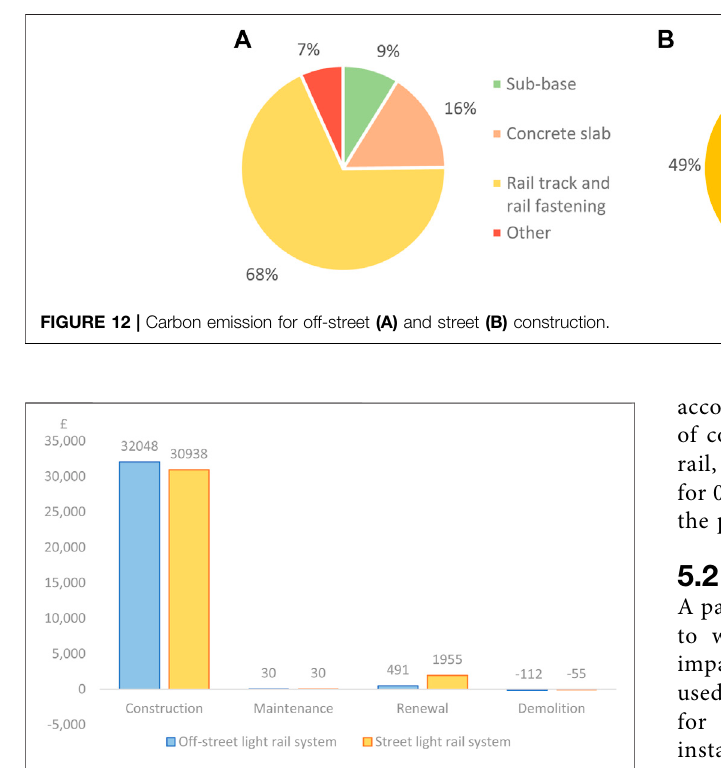
FIGURE 13 | Life cycle cost comparison for two